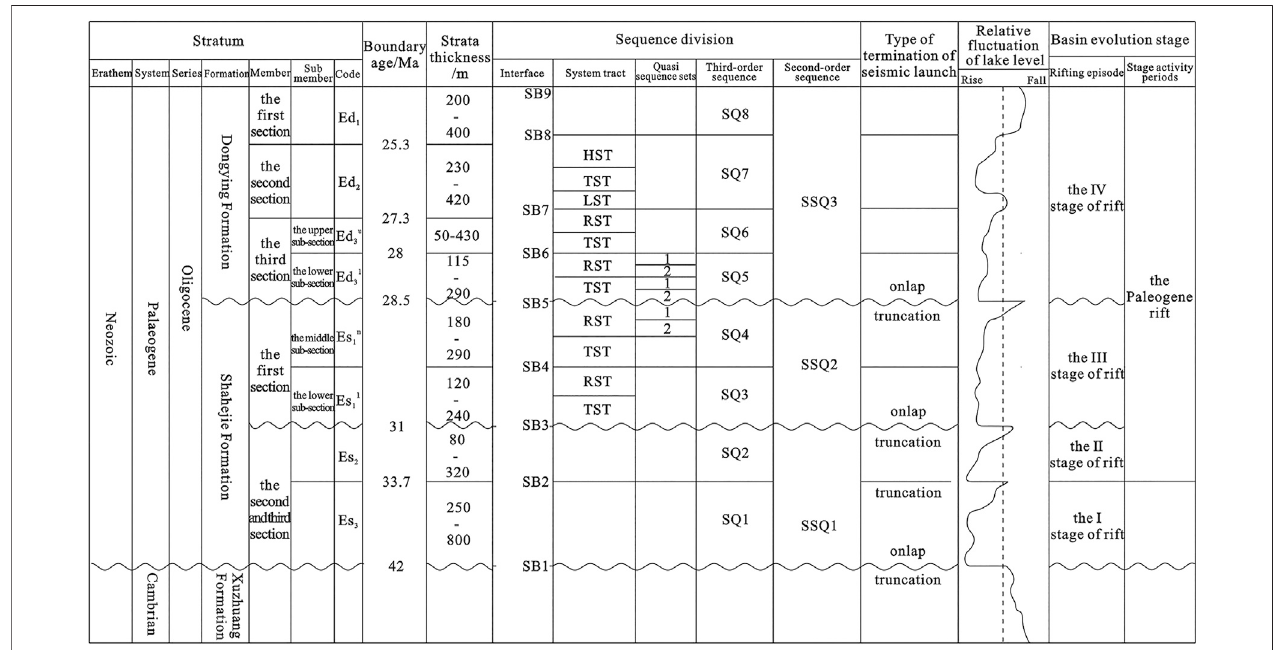
FIGURE 2 | Division and correlation of the Paleogene sequence stratigraphy and lithostratigraphy in the Nanpu No. 3 structural area.